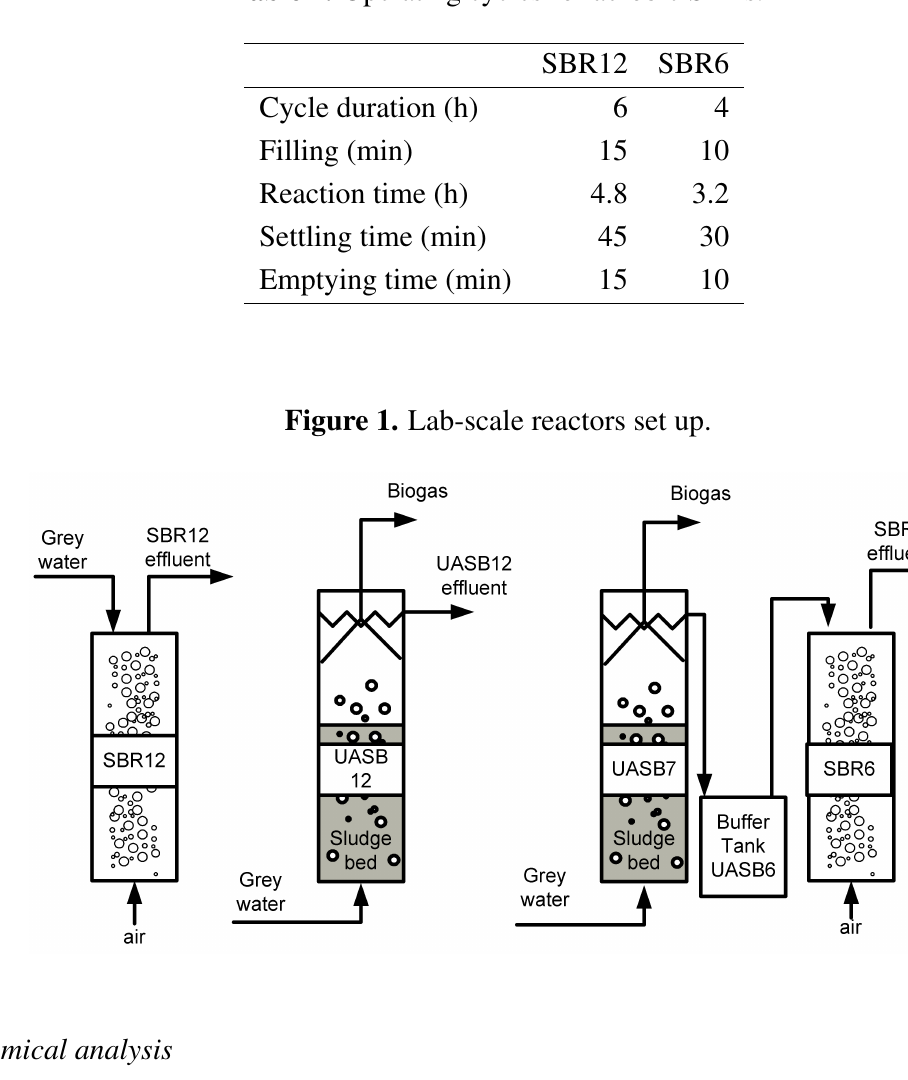
Table 1. Operating cycles for aerobic SBRs.